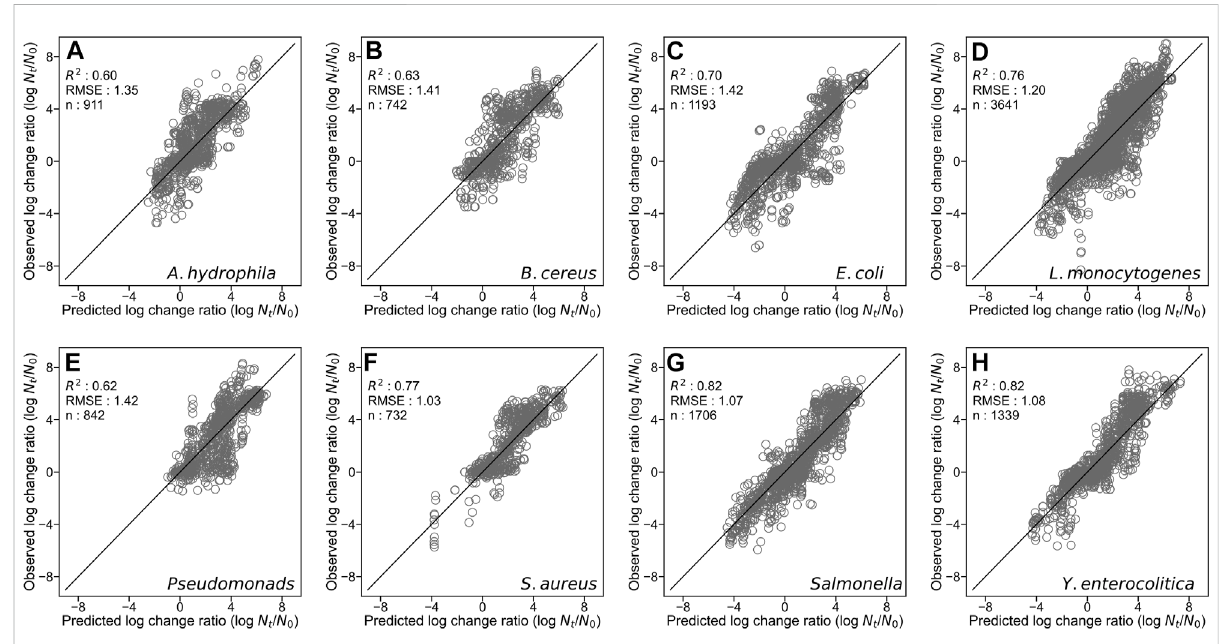
FIGURE 2 Comparison of the predicted and observed log change ratio for test data of Aeromonas hydrophila (A) , Bacillus cereus (B) , Escherichia coli (C) , Listeria monocytogenes (D) , Pseudomonads (E) , Staphylococcus aureus (F) , Salmonella (G) , and Yersinia enterocolitica (H) . The solid line represents residuals =